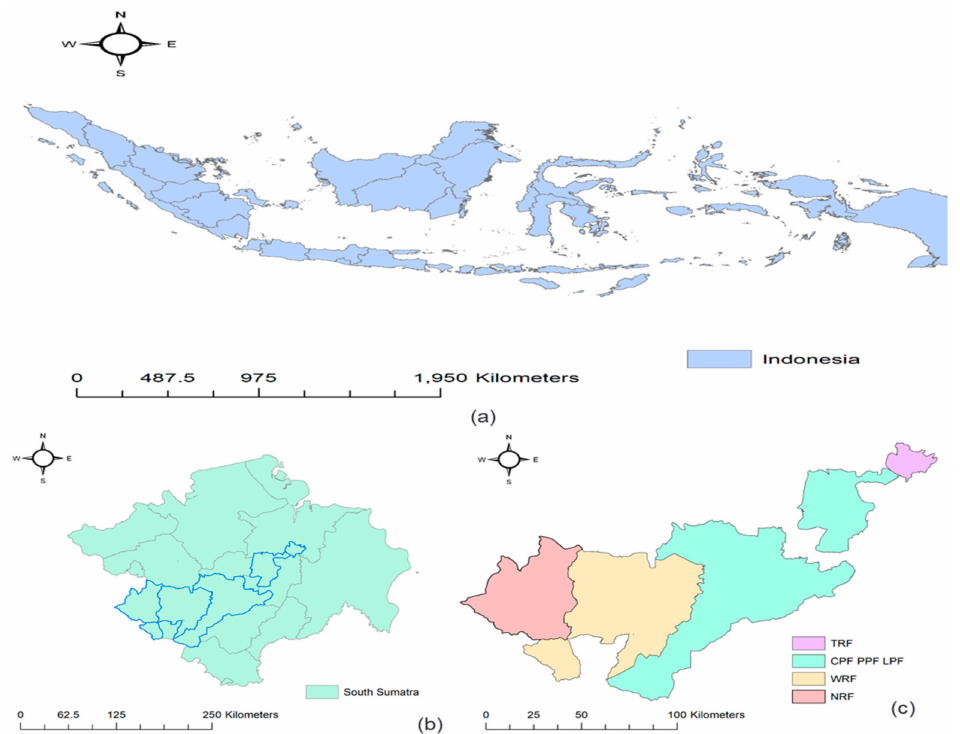
Figure1. GeographicalextentandforestzonesintheSouthSumatraprovinceofIndonesia. ( a )Indonesia, ( b ) South Sumatra and ( c ) the forest zones: Tourism Recreation Forest (TRF), Convertible Protection Forest (CPF), Permanent Production Forest (PPF), Limited Production Forest (LPF), Wildlife Reserve Forest (WRF) and Nature Reserve Forest